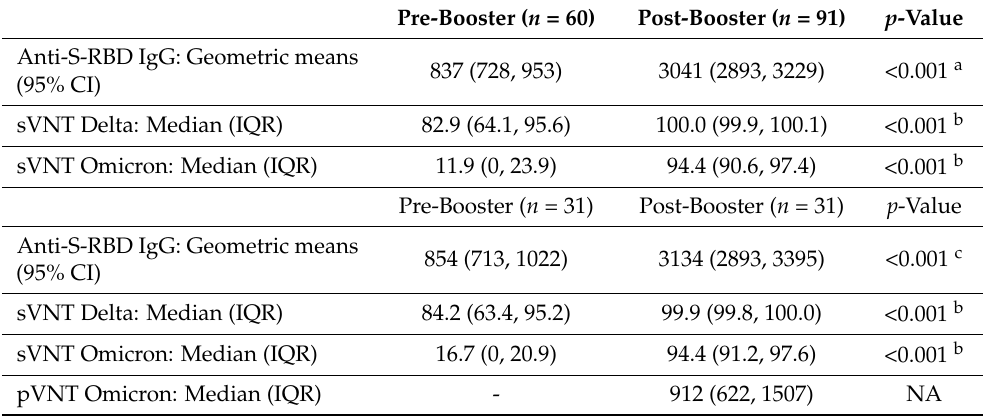
Table 2. Immunogenicity outcomes in healthy adolescents prior to and post receiving a BNT162b2 mRNA vaccine booster